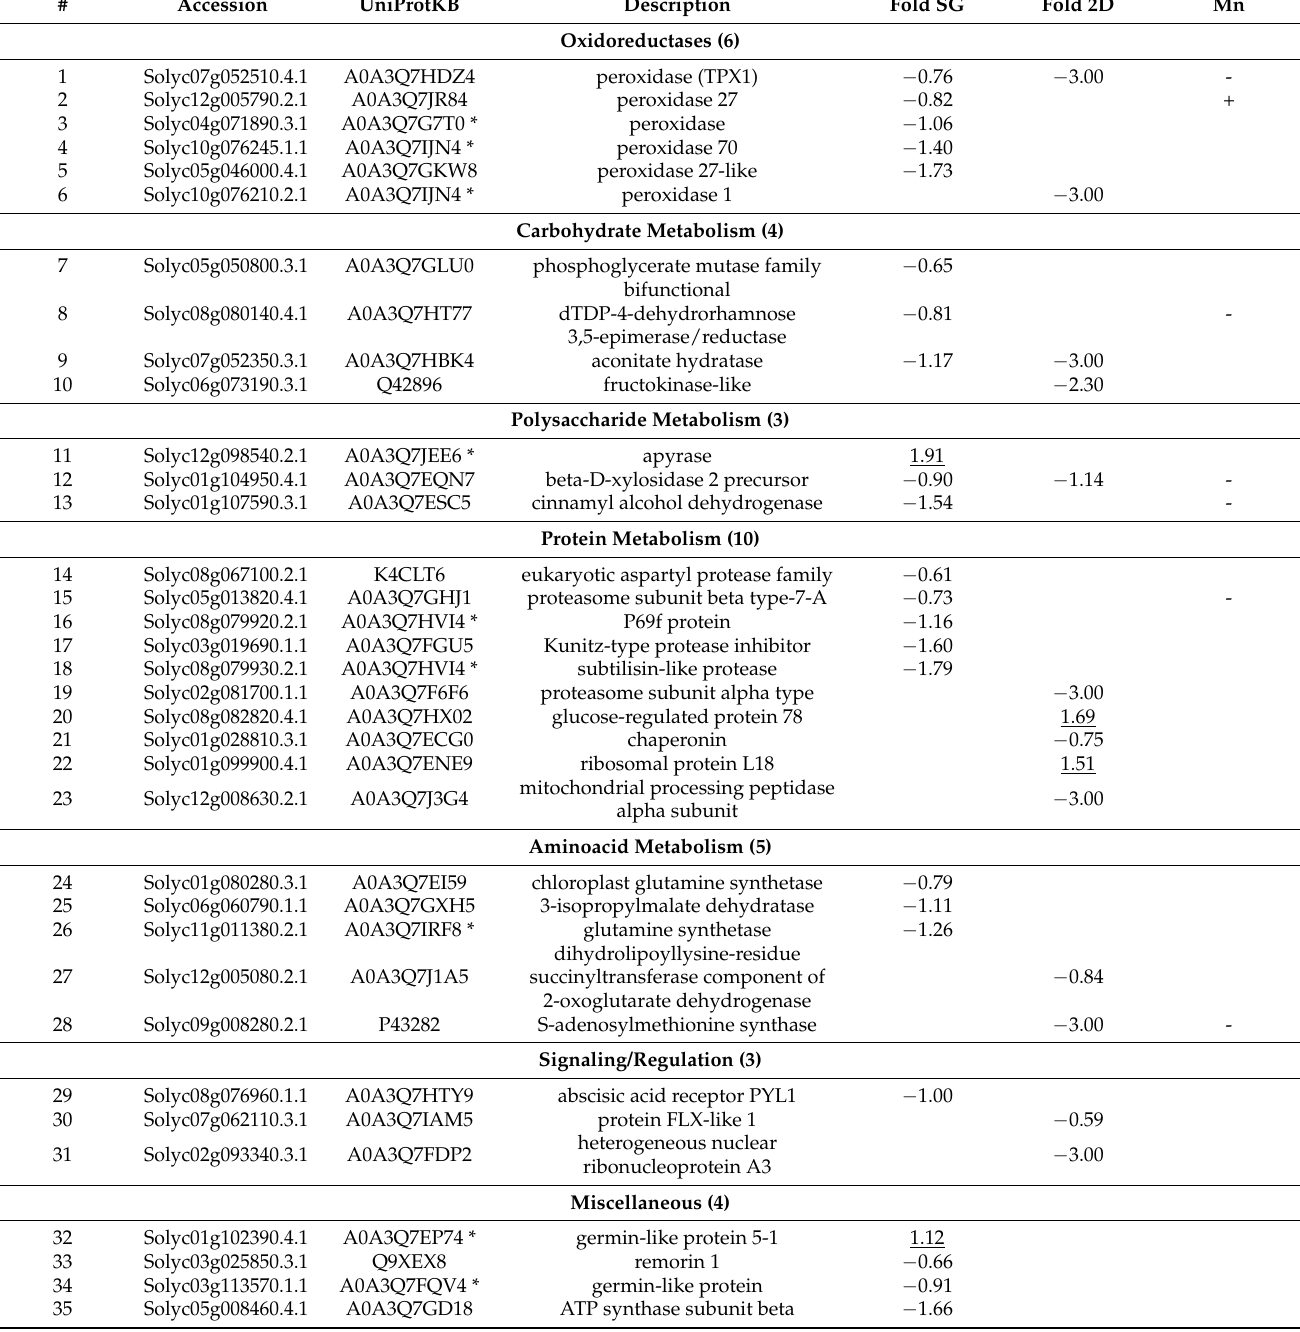
Table 2. Identified and quantified proteins (35 in total) changing in relative abundance by Fe deficiency. Accession code is from the ITAG 4.0 database. Fold SG—fold change found between Fe-deficient and control samples by shotgun in a log 2 base. Fold 2D—fold change found between Fe deficient and control samples by 2-DE. Relative abundance increases are underlined for the sake of clarity. Mn—response observed in Mn-deficient samples compared to controls ( − decreased abundance, + increased